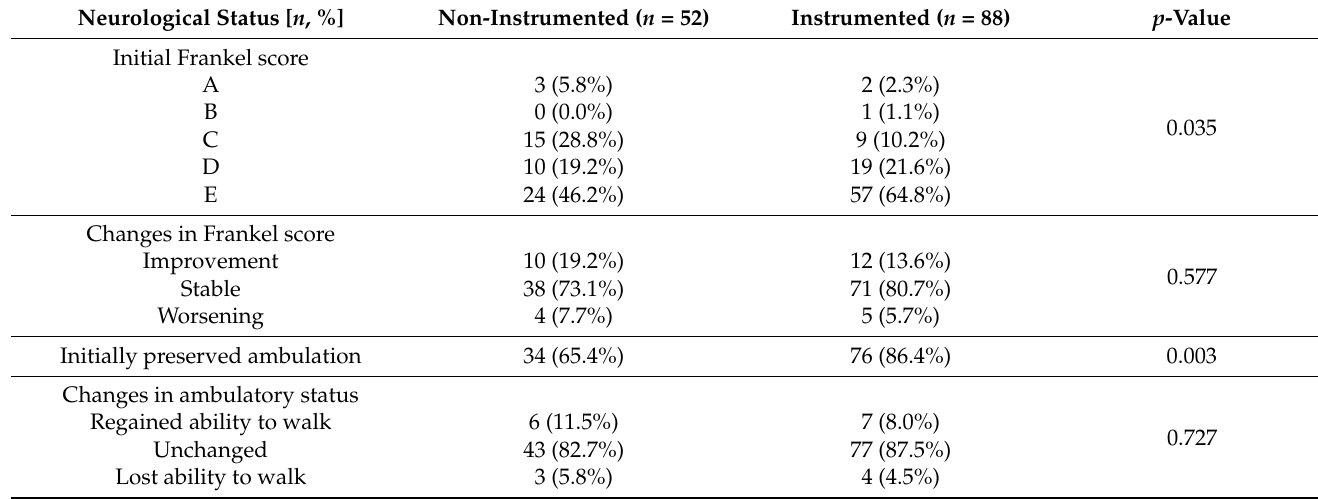
Table A4. Frankel score and ambulatory status in instrumented and non-instrumented patients with SINS 7 to 9.